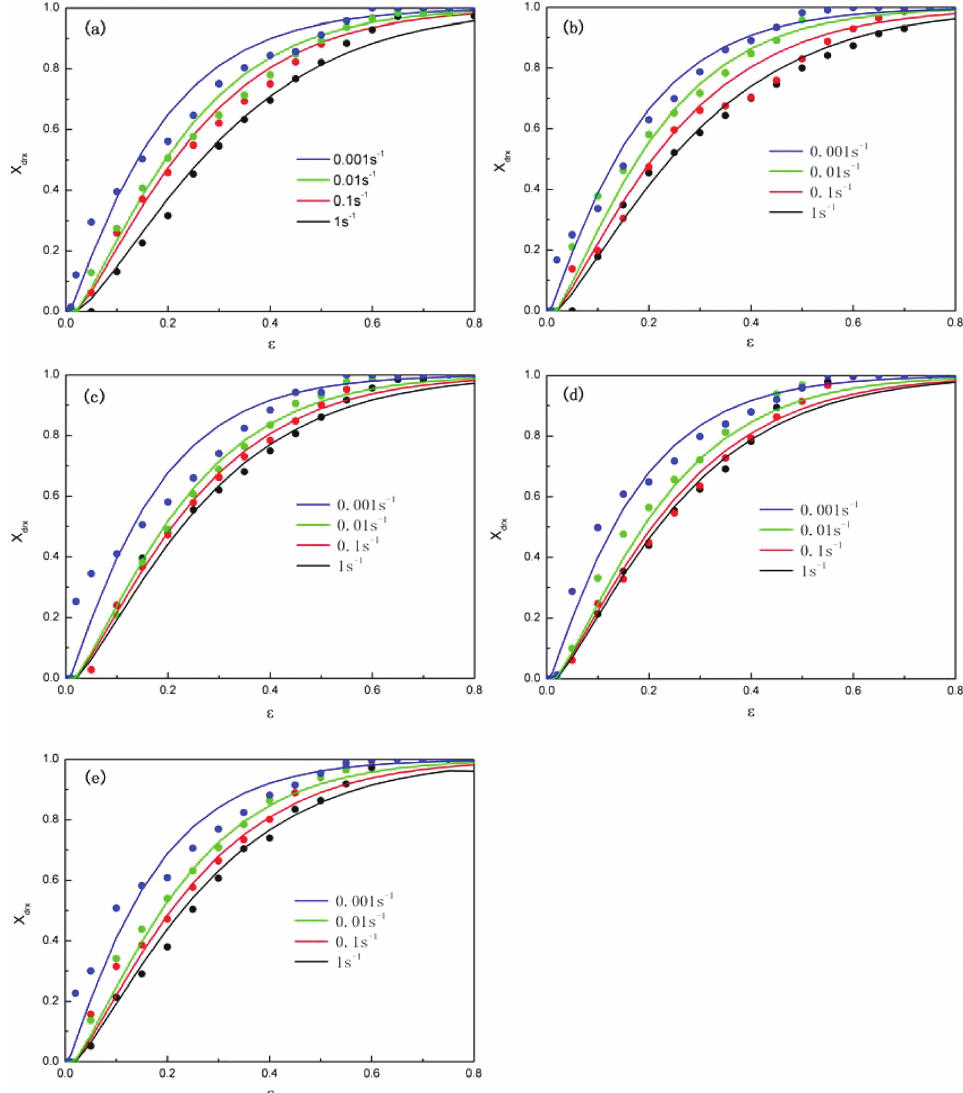
Figure 13: Comparison between measured and predicted X DRX under deformation temperatures of: (a) 1,213 K; (b) 1,233 K; (c) 1,253 K; (d) 1,273 K; (e) 1,293 K. (The symbols represent measured results, the curves represent predicted